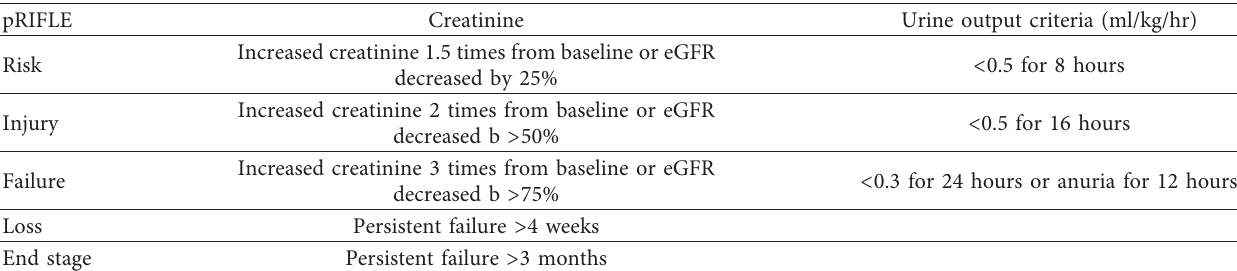
Table 1: The pediatric RIFLE (pRIFLE) criteria adapted for defining the stage of AKI in children with dengue fever.